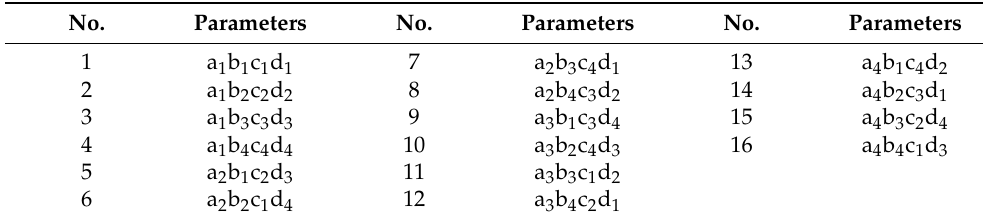
Table 5. Experiment planning matrix.